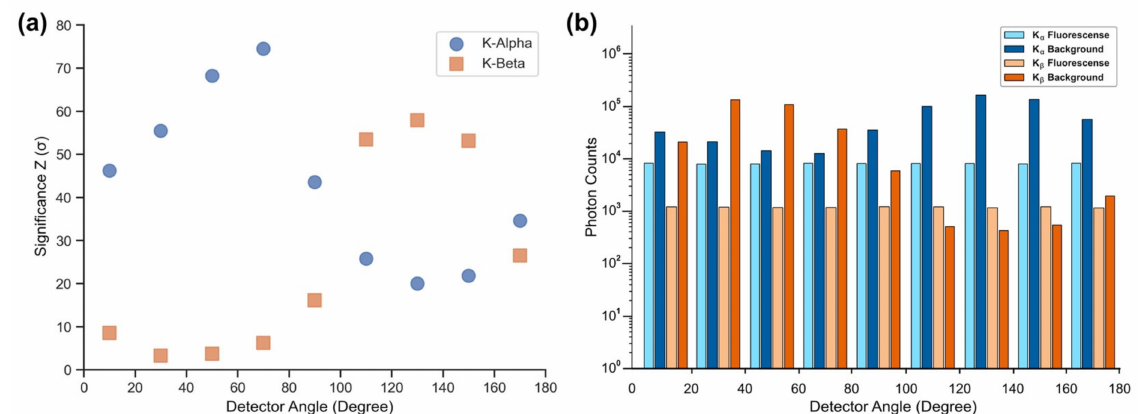
Figure 1. Au fluorescence significance and photon counts as simulated for an agent concentration of 1mg/mL. ( a ) Signifi- cance values for both K α and K β plotted for each of the 9 detector angles. ( b ) Box chart displaying the detected photon counts for both K α and K β fluorescence photons and background photons at the different detector